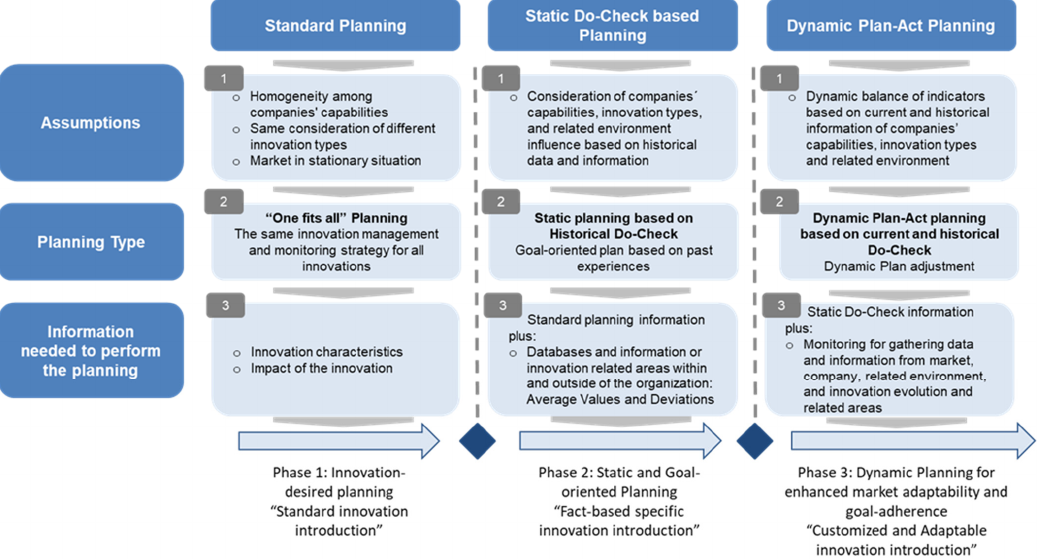
Figure 10. Innovation Project Planning Methodologies based on the PDCA approach (own elaboration).